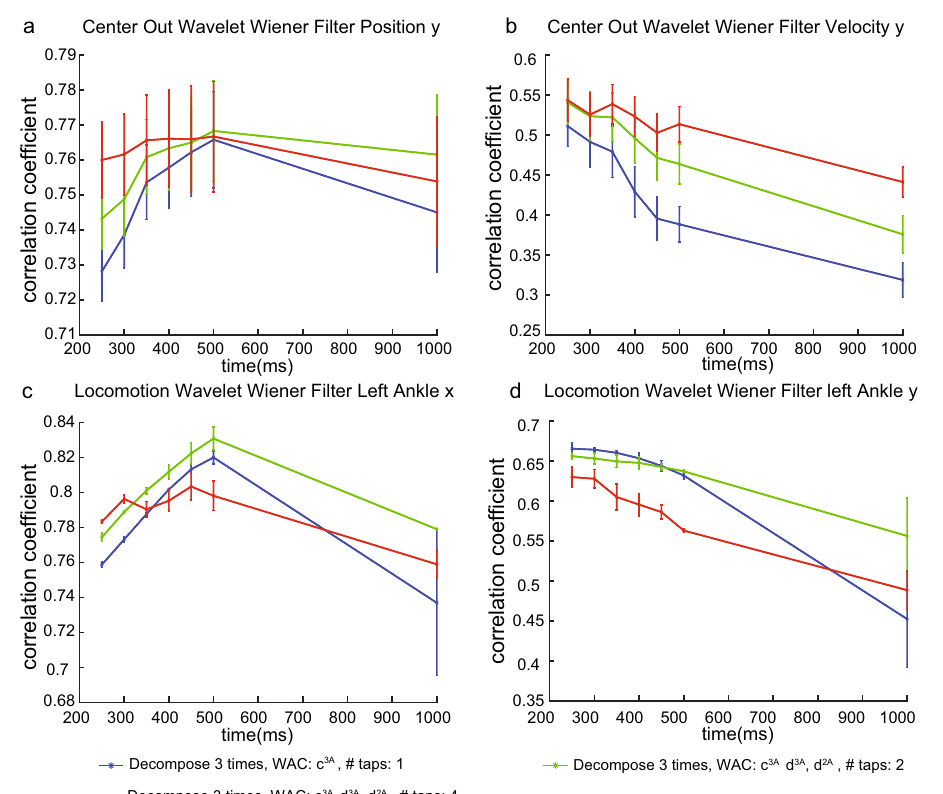
Figure 6. Influence of window size and different hyperparameters measured by correlation coefficient between decoded covariates and ground truths in 5-fold cross-validation (mean + / − S.D., n = 5 folds, 5 ms temporal resolution). ( a , b ) Monkey 1’s center out task for cursor position y and velocity y, 10 ms slide size, 50 ms lag size, db3 basis. ( c , d ) monkey 3’s locomotion task for left ankle x and ankle y, 10 ms slide size, 50 ms lag size, db3 basis.